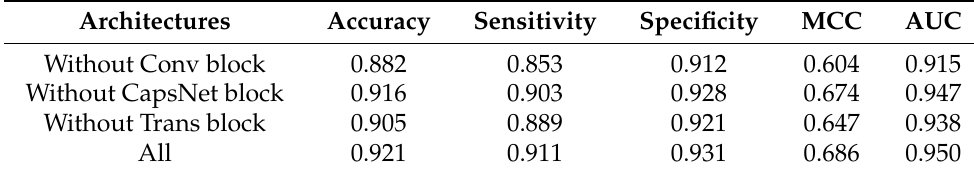
Table 7. Performance of different architectures for predicting blood-secretory proteins on the train- ing set.